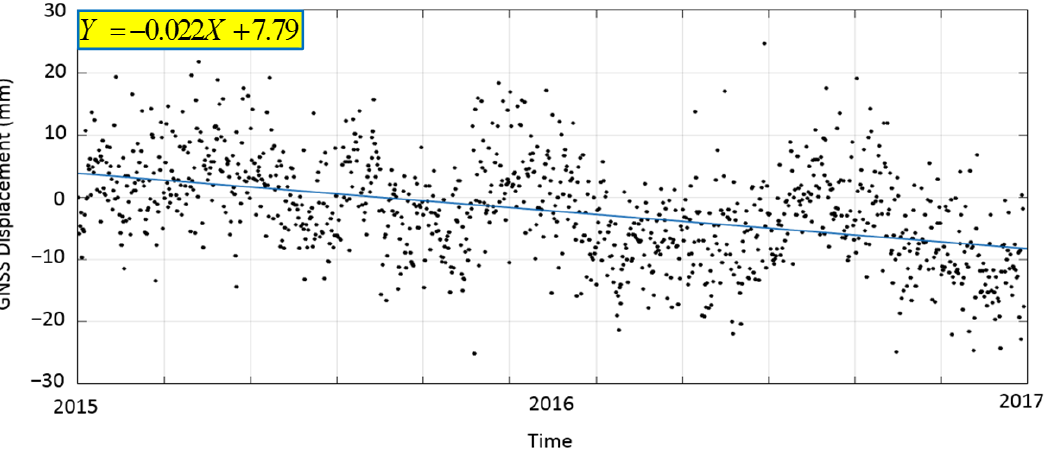
Figure 3. Time series of vertical components for a selected GNSS station and the linear fitting.